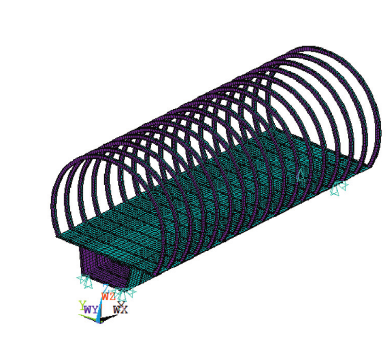
Figure 12: FE model of the bridge-FESB